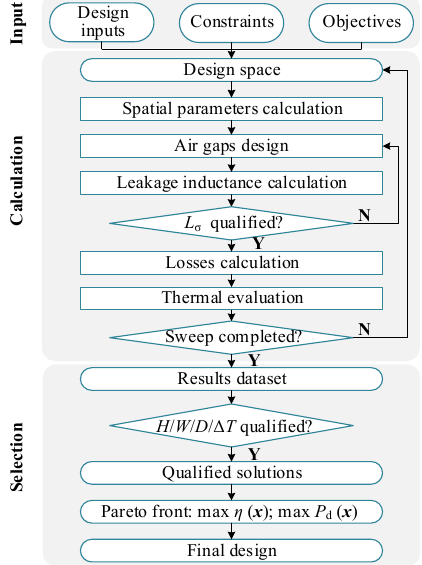
Figure 19. Design procedures of the CW ELII MFT.